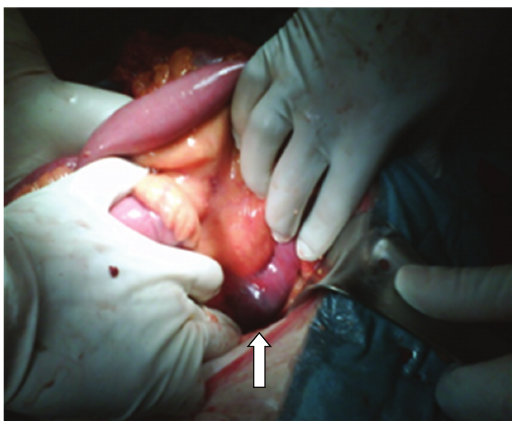
Figure 11: The gallstone located in the first part of the jejunum after successful milking right before jejunotomy (arrow).